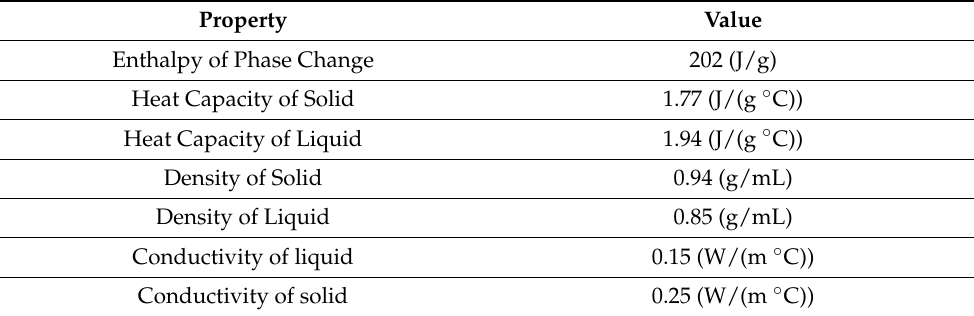
Table 1. Salient Properties of PureTemp29